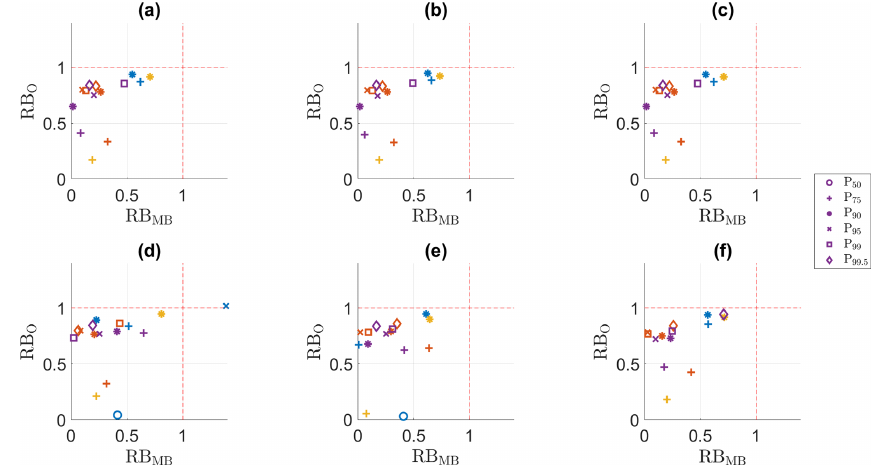
Figure 2. RB MB versus RB 0 for the precipitation in the validation period. (a) QDM, (b) mQDM, (c) MBCn, (d) MRQNBC, (e) dOTC, (f) R 2 D 2 . Winter: blue, spring: ochre, summer: yellow, autumn: purple. Table 6. PSS values for temperature in the calibration (Cal) and validation (Val) periods (%).